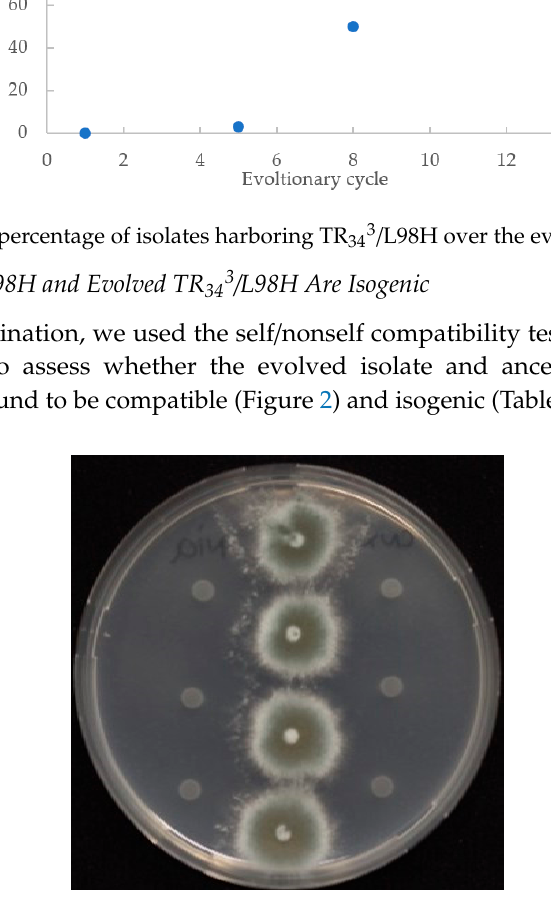
Figure 2. Heterokaryon compatibility test on agar with nitrate as the sole N-source. Left: ancestor TR 34 /L98H nia mutant, right: evolved TR 343 /L98H cnx mutant. Middle, the mixture of the TR 34 /L98H nia and TR 34 3 / L98H cnx mutants from left and right. The figure shows that the strains were heterokaryon through complementation in a heterokaryon. From top to bottom, 4 replicates are